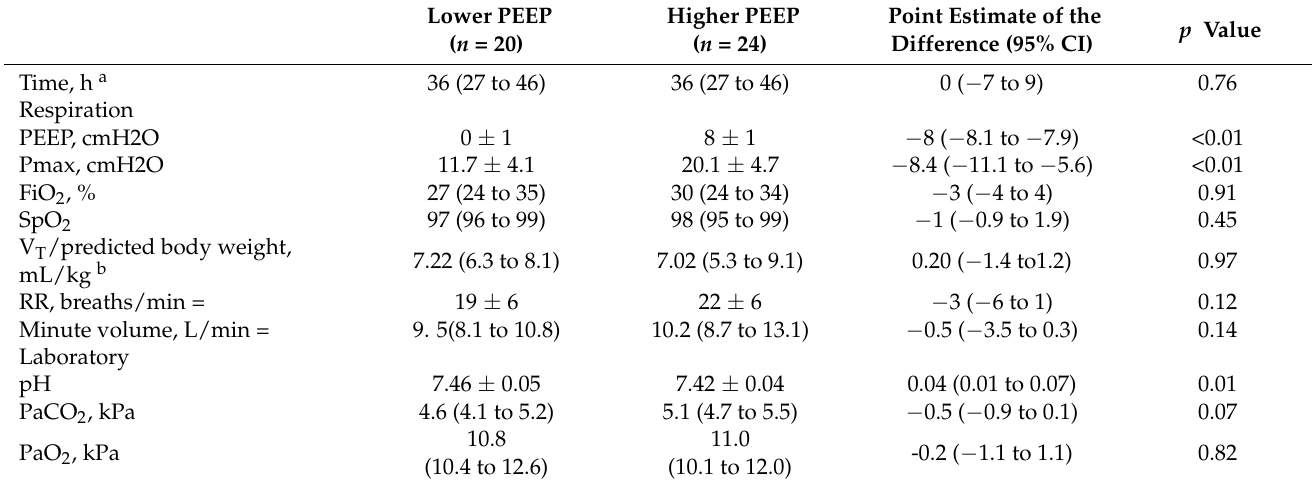
Table 2. Respiratory and hemodynamic parameters at transthoracic echocardiographic